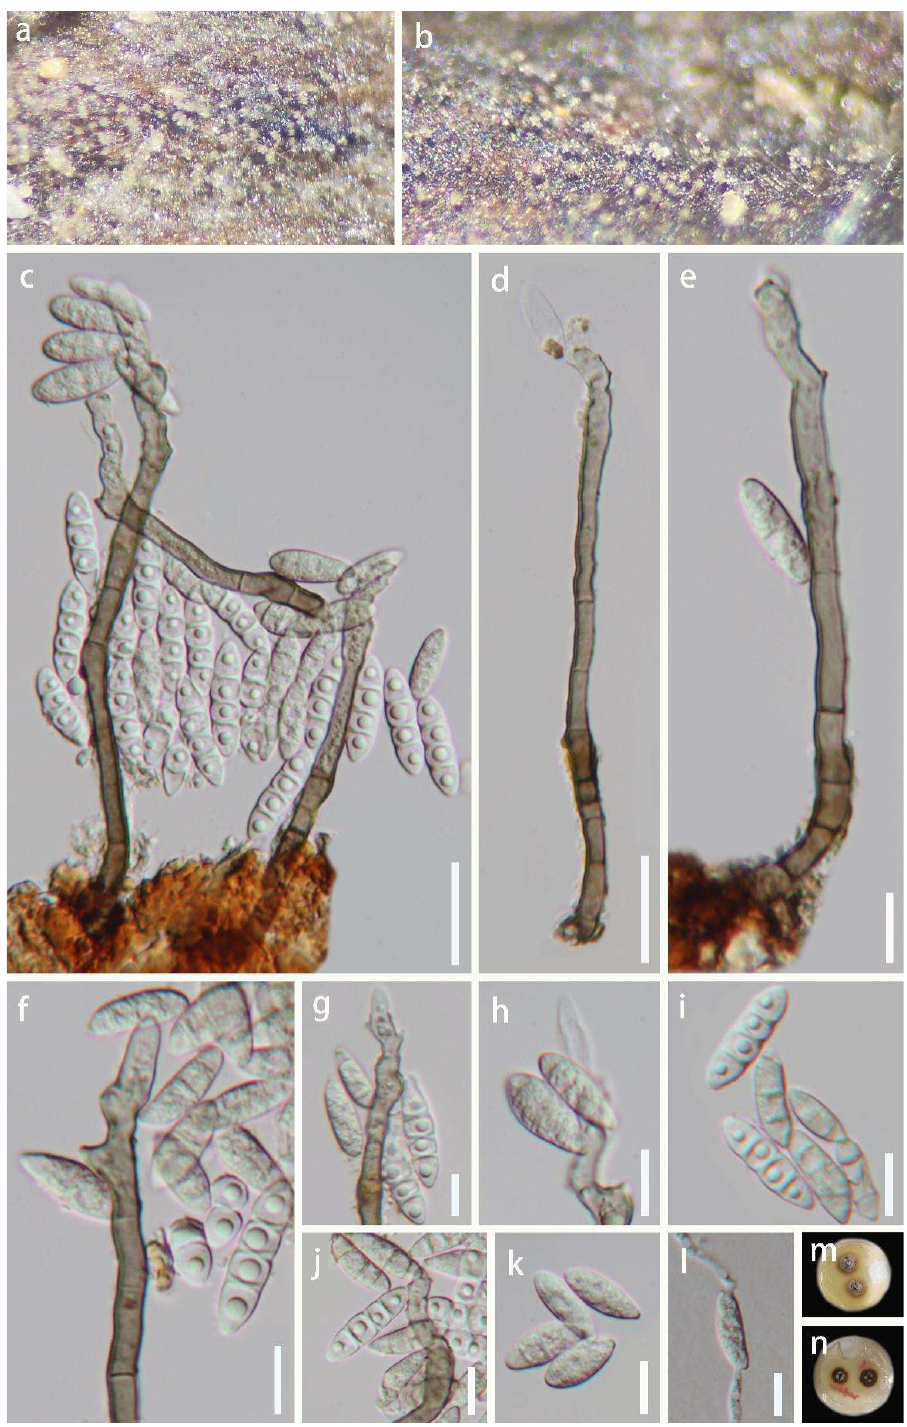
Figure 3. Aquapteridospora hyalina (HKAS 123764, holotype). ( a , b ) Colonies on the host surface. ( c – e ) Conidiophores, conidiogenous cells with attached conidia. ( f – h ) Conidiogenous cells bearing conidia. ( i – k ) Conidia. ( l ) Germinated conidium. ( m , n ) Colonies on PDA, m from above, n from below. Scale bars: ( e – l ) 20 μm, ( c , d ) 10 μm. Distoseptispora aquisubtropica J. Ma and Y.Z. Lu, sp. nov., Figure 4. Index Fungorum number: IF559686; Facesoffungi number: FoF11334.